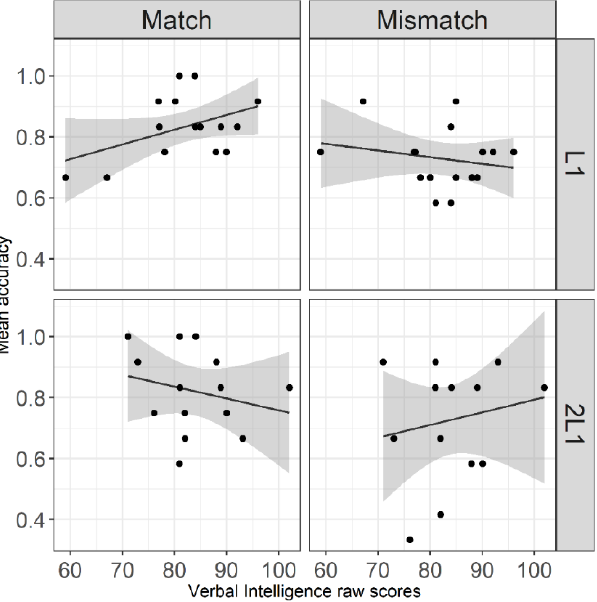
Figure 2. Scatterplot of the accuracy scores and the verbal intelligence scores.